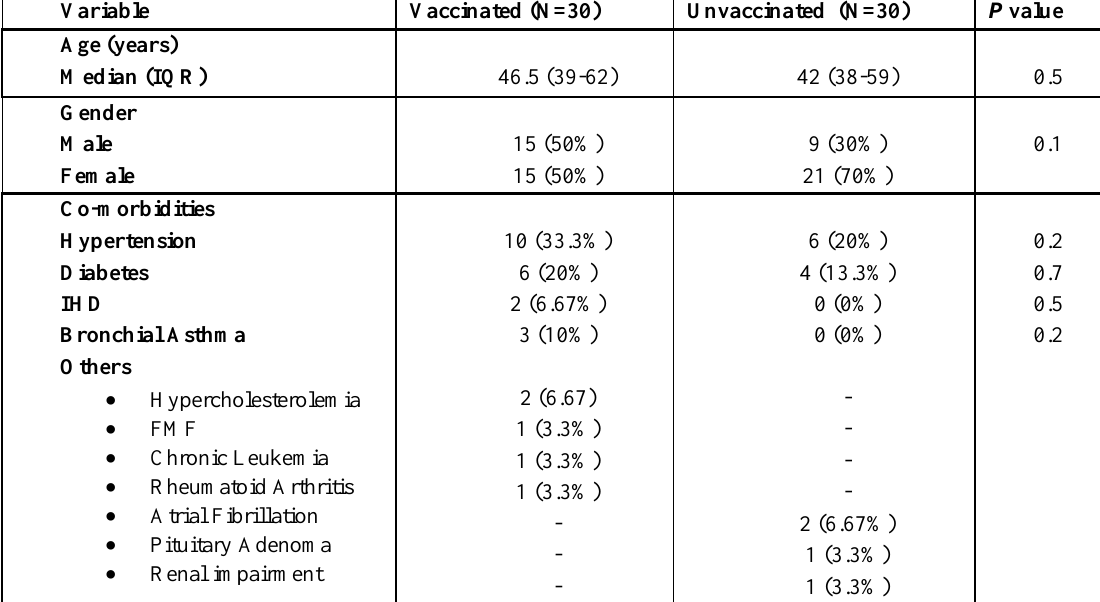
Table I. Baseline demographic and clinical characteristics of the studied